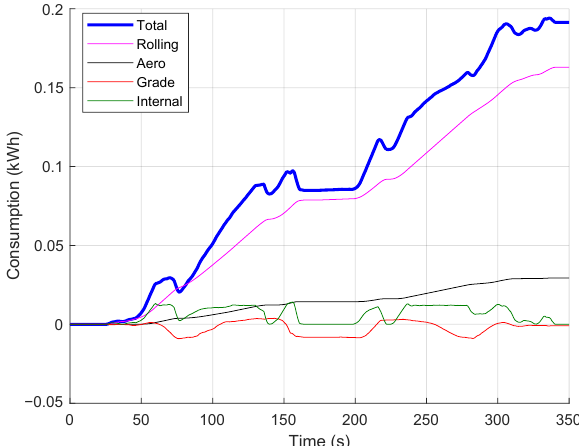
Figure 17. Distribution of consumption according to driving